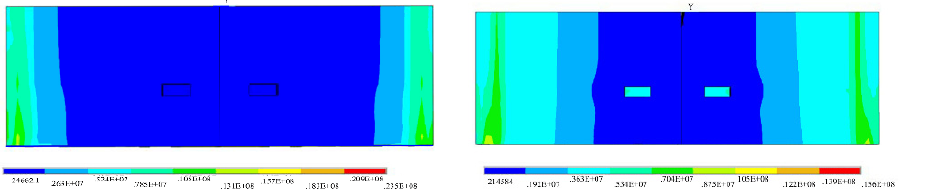
Figure 7. Stress–time curve of internal nodes and surrounding nodes of the hand hole. The stress concentration state of the contact surface between the bolt and the hand hole is precisely the opposite of the hand hole. When the bolt is not stressed, the stress on the contact surface of the bolt and the hand hole is greater than the stress on the middle and lower nodes, as shown in Figure 8. The stress is centered on the contact surface at this moment, which is mostly due to the geometry of the hand hole. The node stress rapidly grows once the bolt joins the force until it exceeds the stress concentration effect given by the hole form. The tensile force of the bolt increases with time, forcing the concrete on the bolt contact surface and the concrete on the compression side to yield simultaneously. In the process of designing the shield tunnel with high water pressure, multiple rows of bolts or contact surfaces large enough should be used to ensure that the stress is concentrated in the controllable range while balancing the weakening effect of the size of the hand hole on the segmental joint.